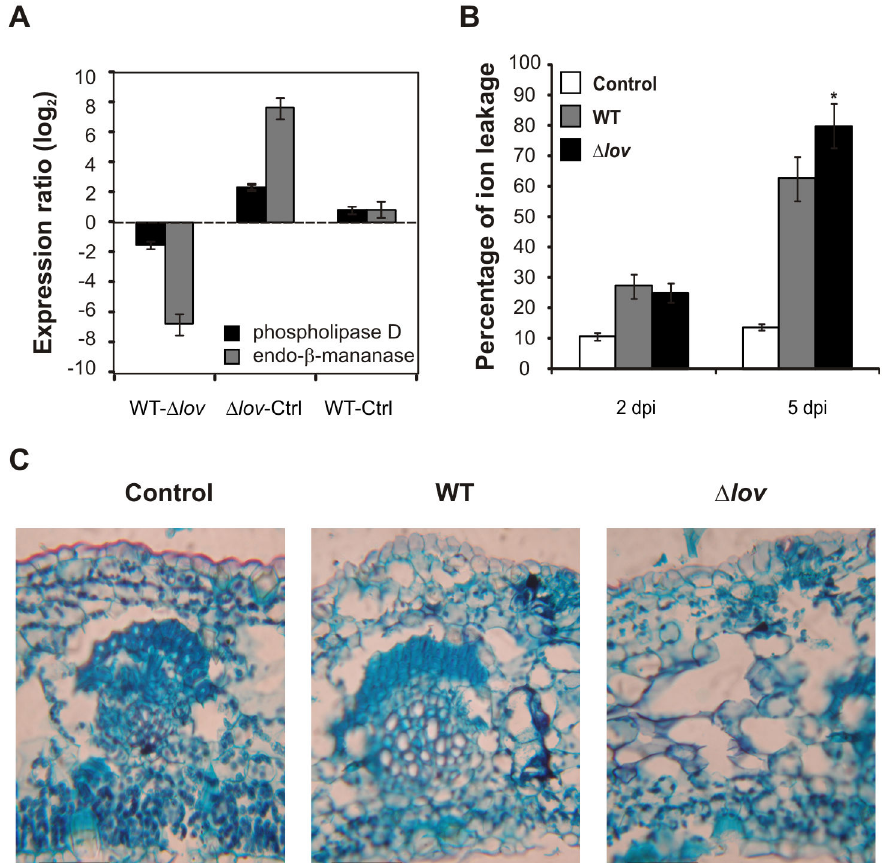
Figure 5. Tissue integrity upon orange interaction with WT and Δ lov strains of Xanthomonas citri subsp. citri. ( A ) Analysis of log of expression ratio between treatments (M) of a Citrus EST corresponding to a phospholipase D (orange1.1g003057m of 2 Citrus sinensis ) and an endo-β-mannanase (orange1.1g013811m of C. sinensis ). Data are averages of values obtained from three independent biological samples. Bars represent standard error. Accession numbers correspond to the complete C. sinensis genes taken from the phytozome database (http://www.phytozome.net/citrus.php). Ctrl: control treatment (10 mM MgCl ) ( B ) Ion leakage 2 measurements were performed in bacterial- and control (10 mM MgCl )-inoculated orange leaves at 2 and 5 days post inoculation 2 (dpi). Results are expressed as percentage of ion leakage and represent the mean of three independent biological replicates. Error bars represent the standard deviations. Asterisks indicate significant differences between WT and Δ lov treatments (p<0.05). ( C ) Structure and organization of inoculated-leaves fragments were analyzed by safranine/fast green staining. Panels show the microscopic visualization of stained tissue fragments 7 days after bacterial and control treatments using a 400X magnification. Scale bars: 10 µm. Identical results were obtained with three independent biological samples, 90% of the optical fields analyzed for each biological replica rendered the same